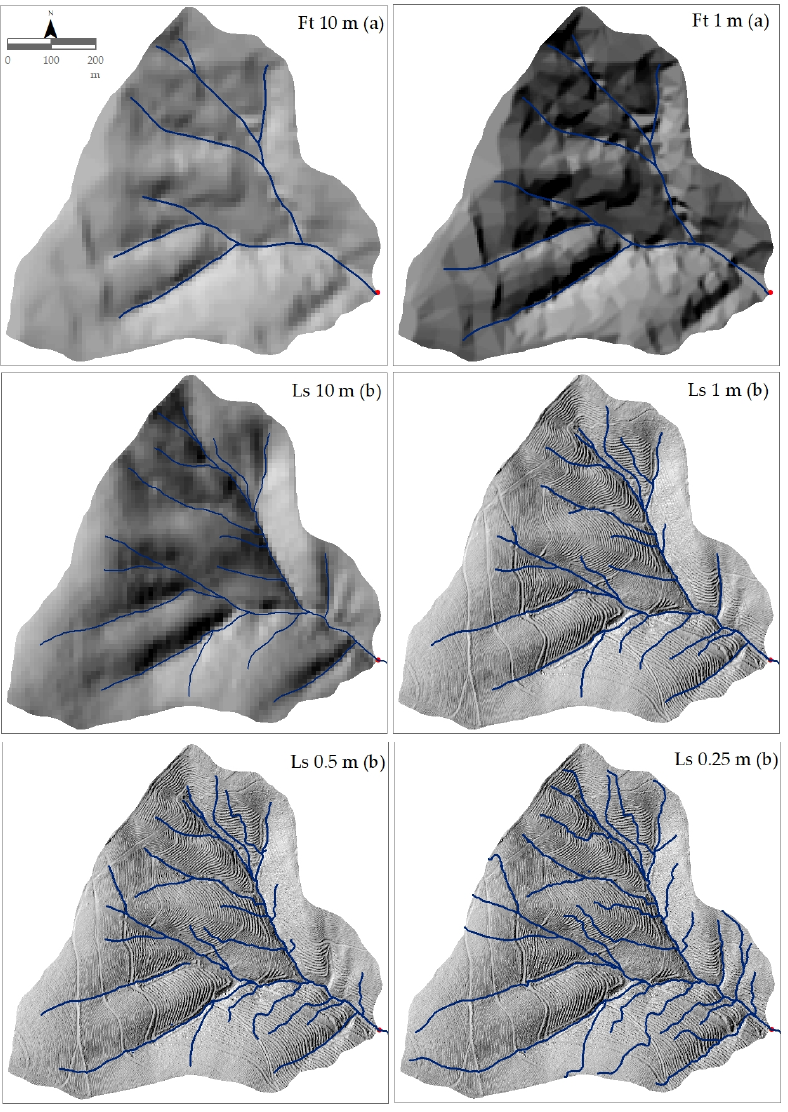
Figure 4. DEMs for the Braçal catchment: ( a ) 10 m and 1 m Ft DEMs; ( b ) 10 m, 1 m, 0.5 m, 0.25 m Ls DEMs. The 0.10 m Ls DEM denoted some incongruences on the actual representation of the topographic surface and morphometric features. These constrains may be linked with dense vegetation that inhibits laser ground return signal and with the two individual returns (low density number of returns) per pulse from the LiDAR survey. Dense canopy and ground vegetation can reduce the penetration of LiDAR pulses to the ground especially on complex topography and dense vegetation cover regions [77–79]. Constrains imposed by vegetation patterns in the actual topographic surface representation were also reported by Goulden et al. [24,25], while White et al. [80] found similar constrains of terrain representation using a low-density LiDAR survey. Thus, this very high-resolution